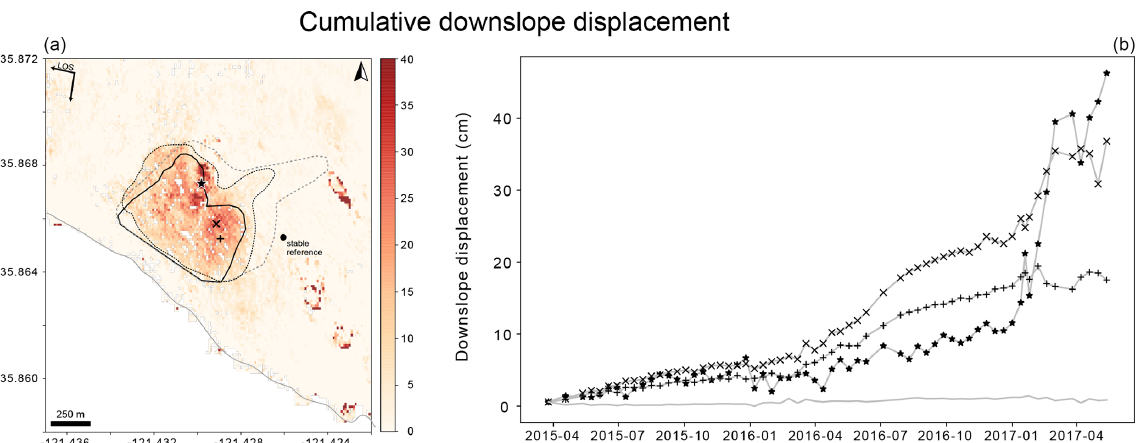
Figure 8. (a) Cumulative line-of-sight displacements from April 2015 to May 2017 projected onto the fall line. The solid black line indicates the extent of the slope that failed, the dashed black line the area showing significant displacement and the dashed gray line the area of low coherence. (b) Time series of displacement at three different points within the slide (indicated by the », × and + signs) as well as in the region used as stable reference (solid